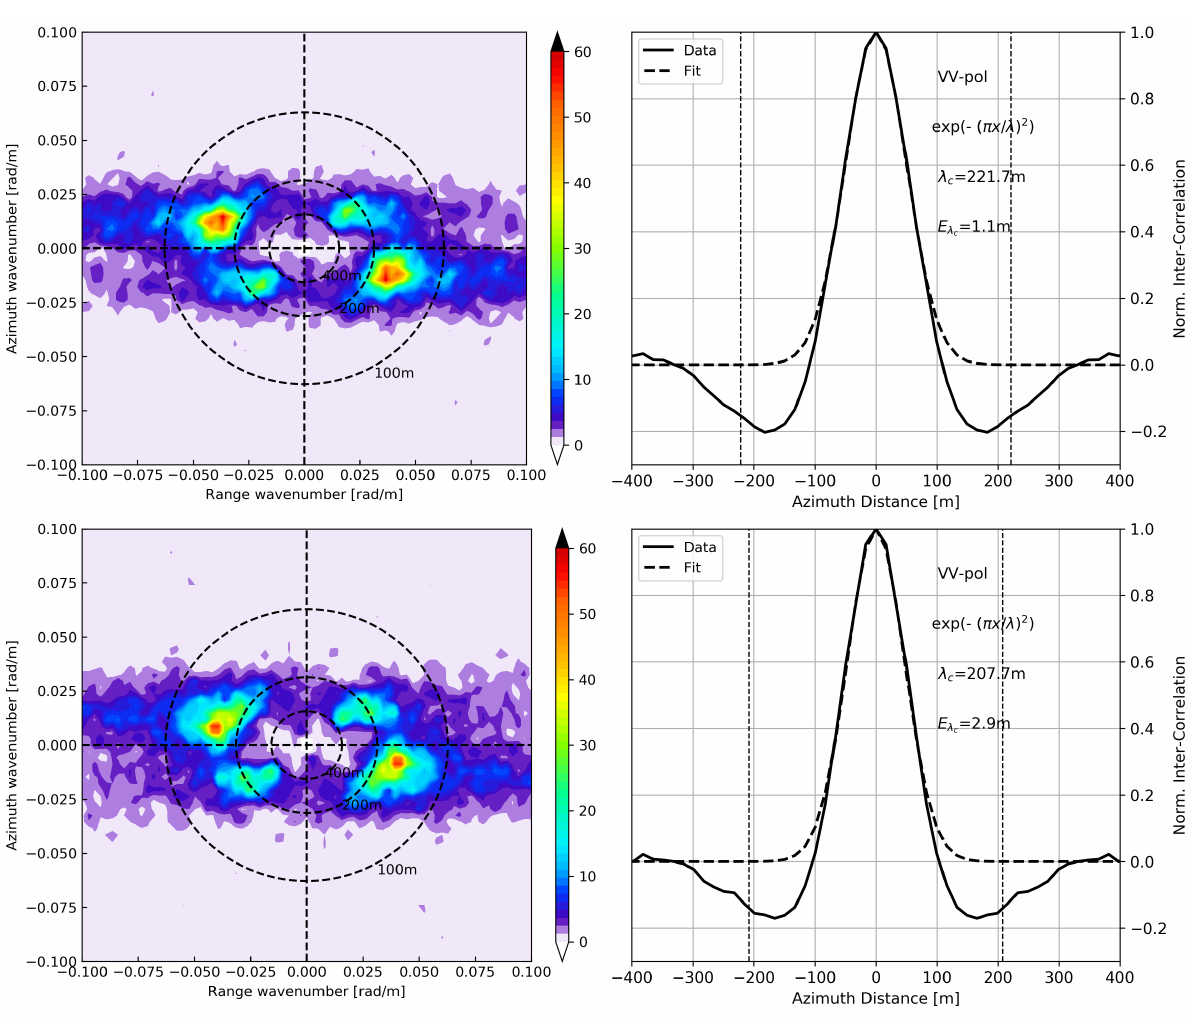
Figure 3. ( Left ) Magnitude of SAR cross-spectrum calculated over the regions of interest shown in Figure 2. ( Right ) The corresponding azimuth cutoff estimate by fitting the normalized correlation function using a Gaussian model with the value and fit error annotated in the